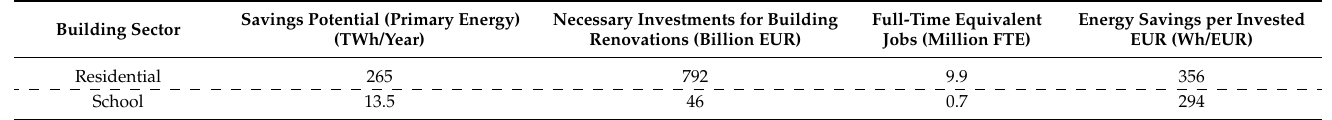
Table 9. Technical savings potential (primary energy), investment needs, FTE jobs and savings per EUR invested associated with the renovation of the Italian residential and educational building